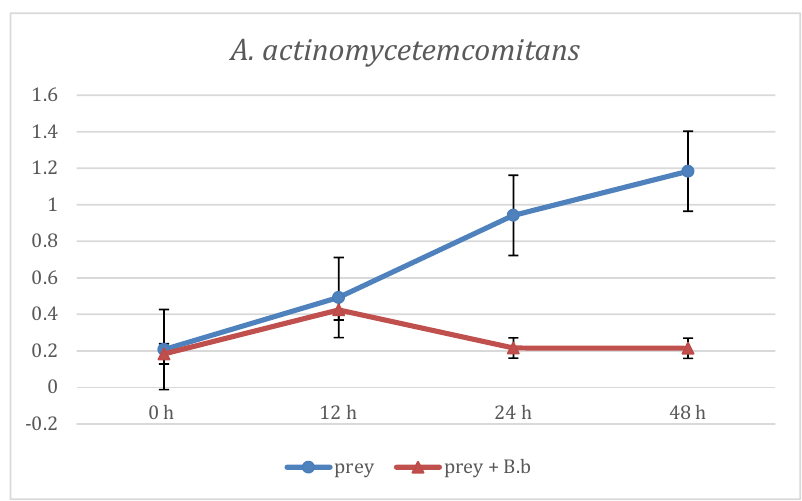
Materials 2019 , 12 , x FOR PEER REVIEW Figure 3. Predation activity of B. bacteriovorus against A. actinomycetemcomitans .